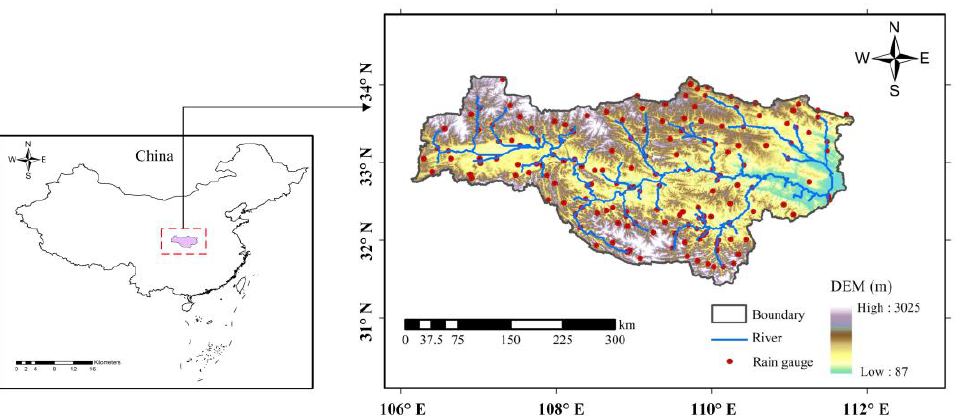
Figure 1. Study area and the location of rain gauges.